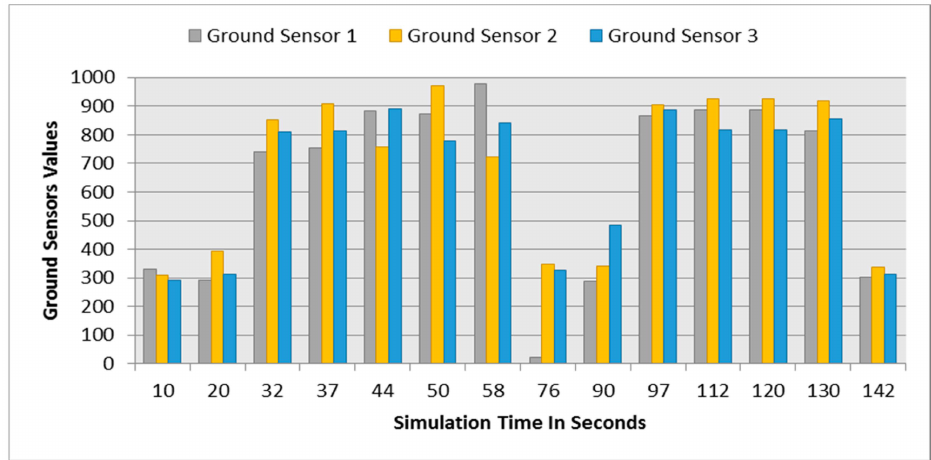
Figure 21. Ground sensor values at different simulation times.